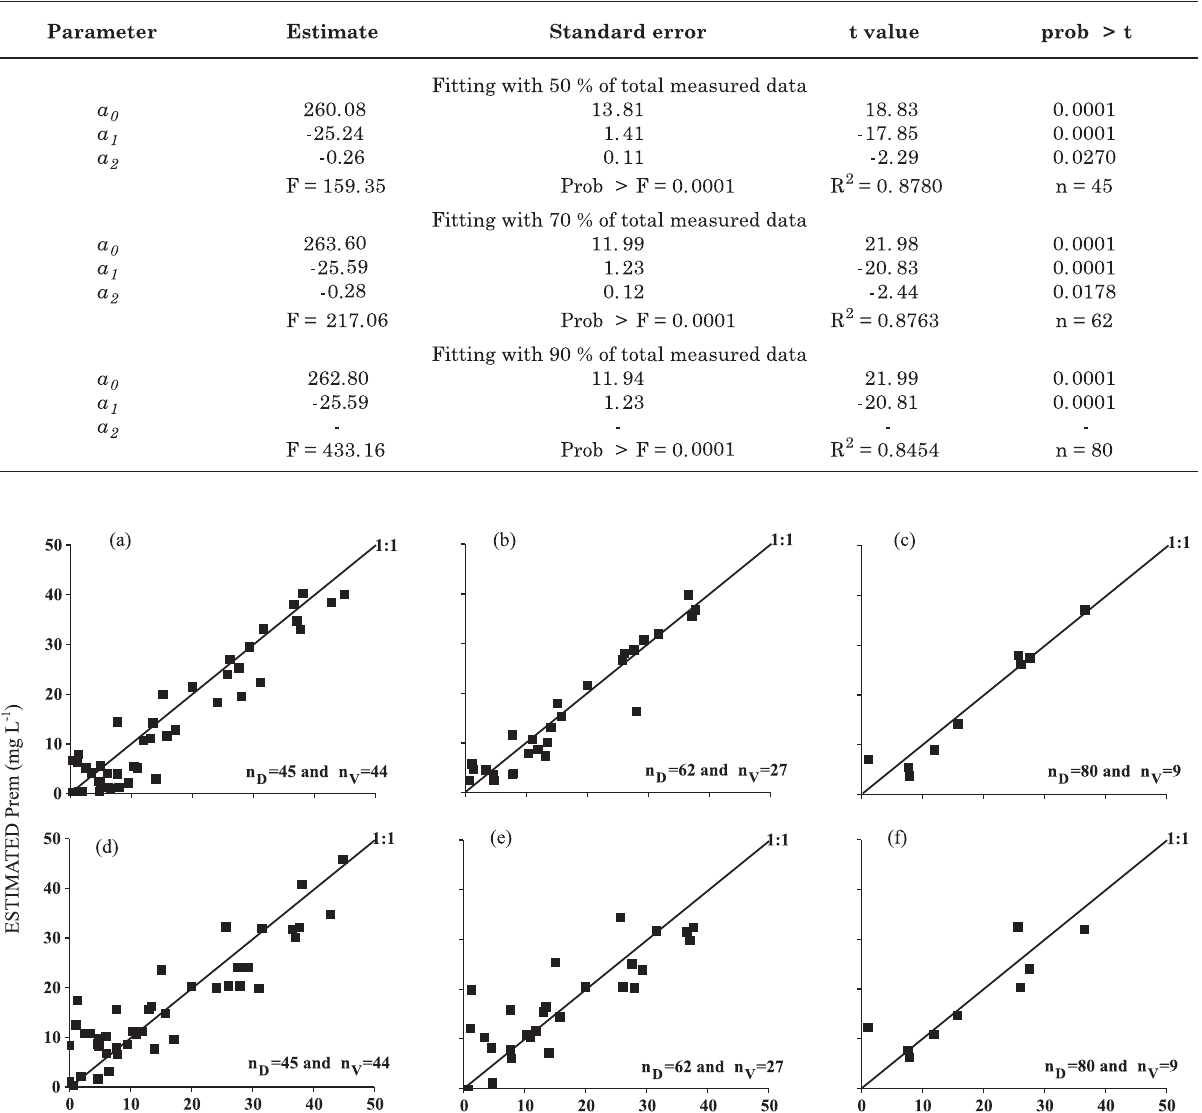
Table 2. Results of the multiple regression analyses relating remaining phosphorus (Prem) to soil